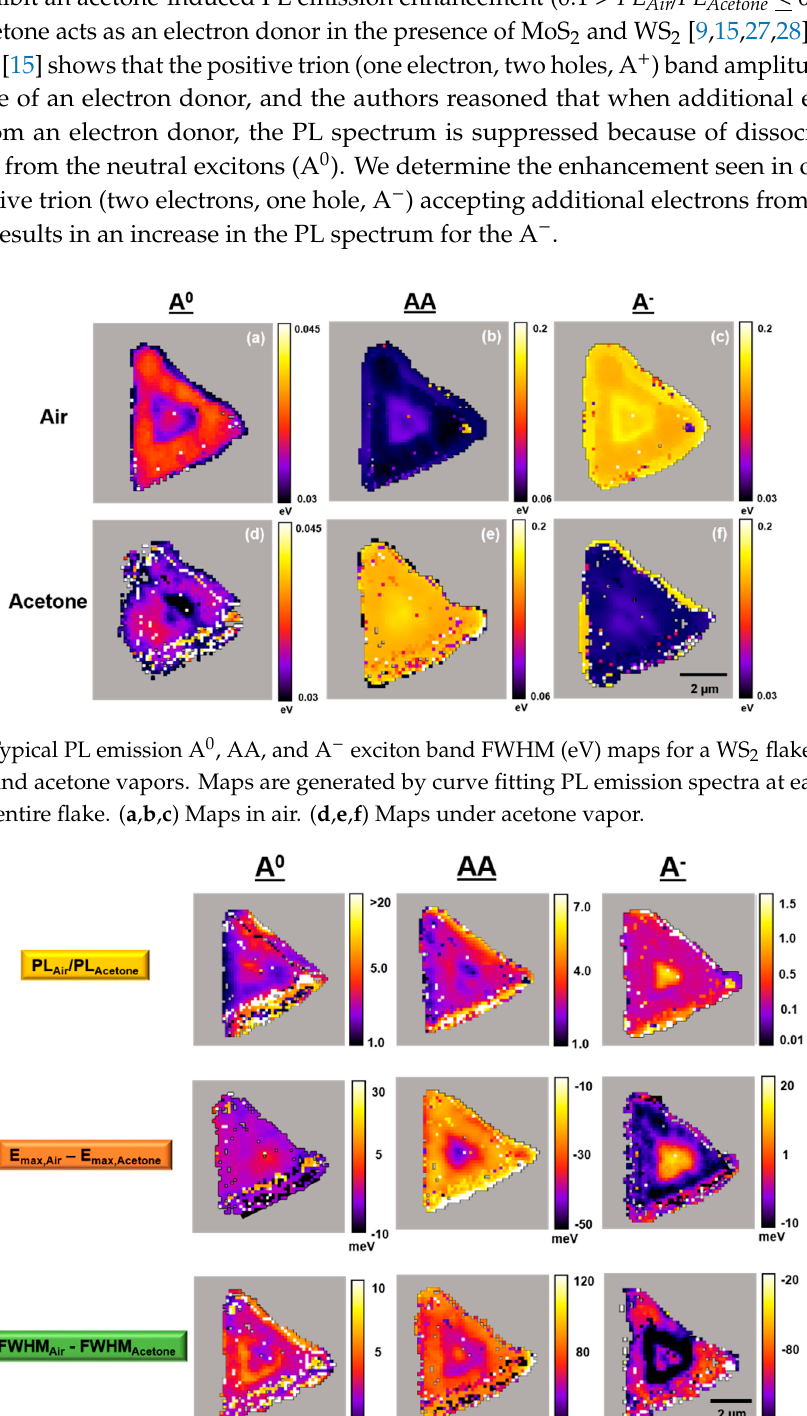
Figure 9. Typical acetone vapor-dependent PL emission A 0 , AA, and A − exciton band intensity ratio